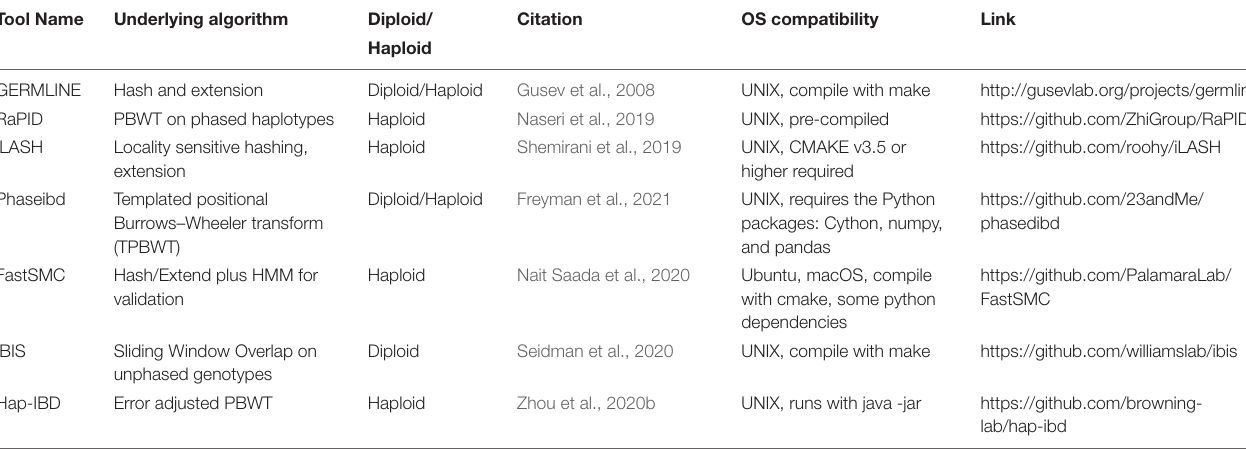
TABLE 1 | Overview of IBD detection